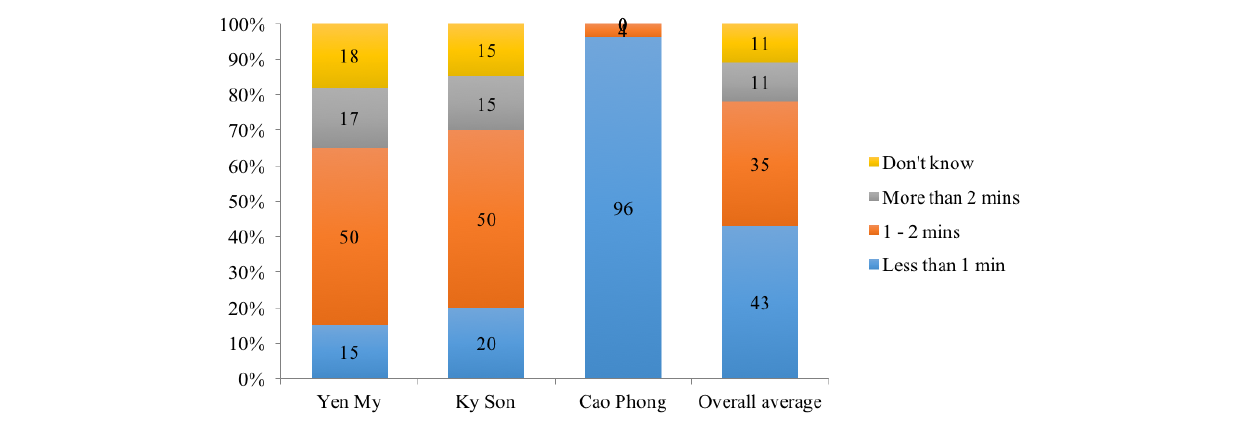
Figure 3. Time spent sending an SMS text message report by district.